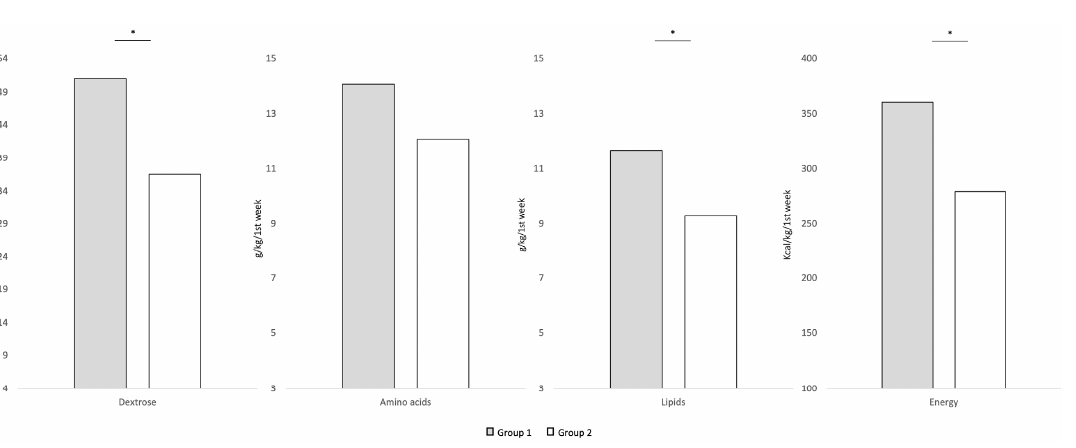
Figure 2. Macronutrient intake administered through PN during the first week of life. Figure legend: * p -value <